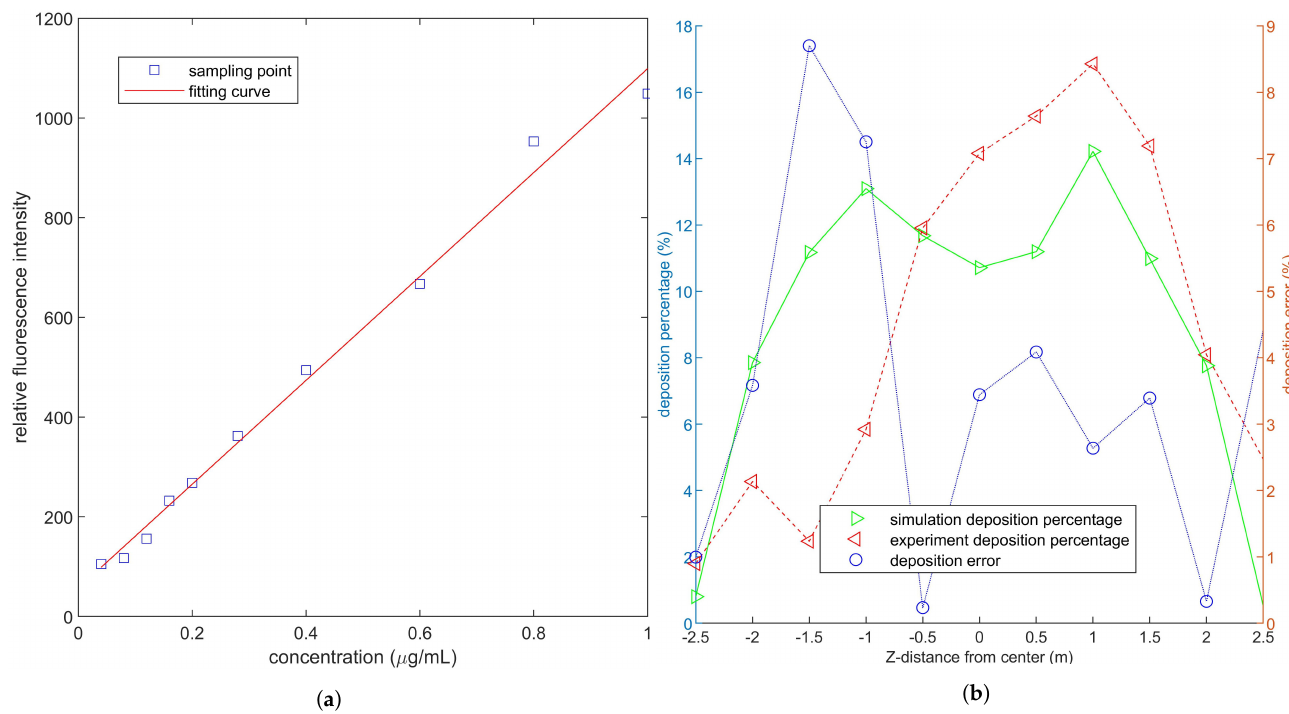
Figure 7. ( a ) shows the standard curve of the relationship between relative fluorescence intensity and solution concentration. ( b ) shows the droplet deposition ratio in the experiment and simulation, and the error between